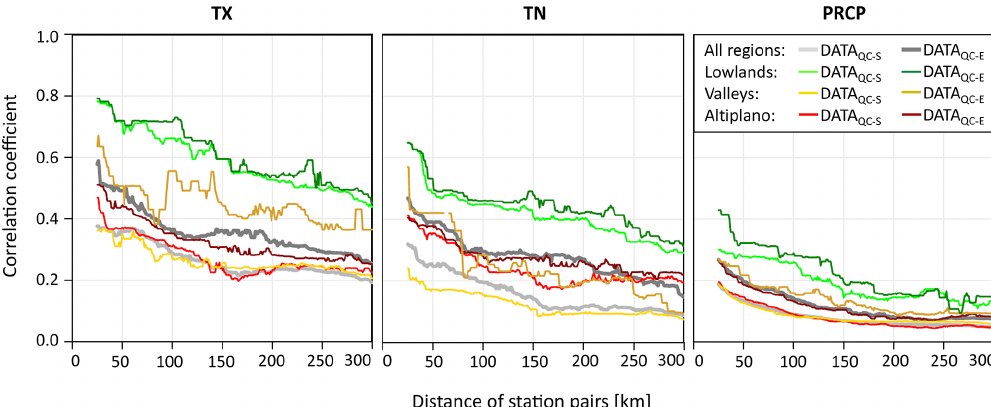
Figure 5. Same as Fig. 4 but for daily